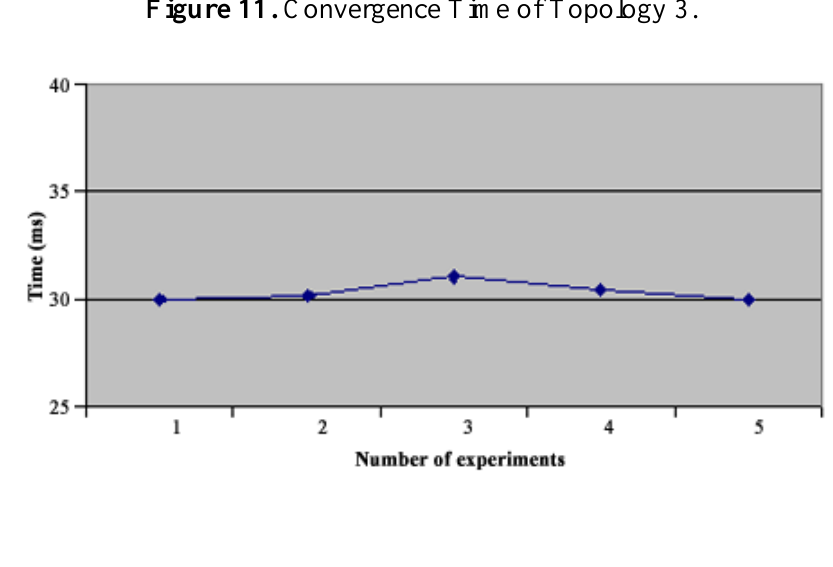
Figure 11. Convergence Time of Topology